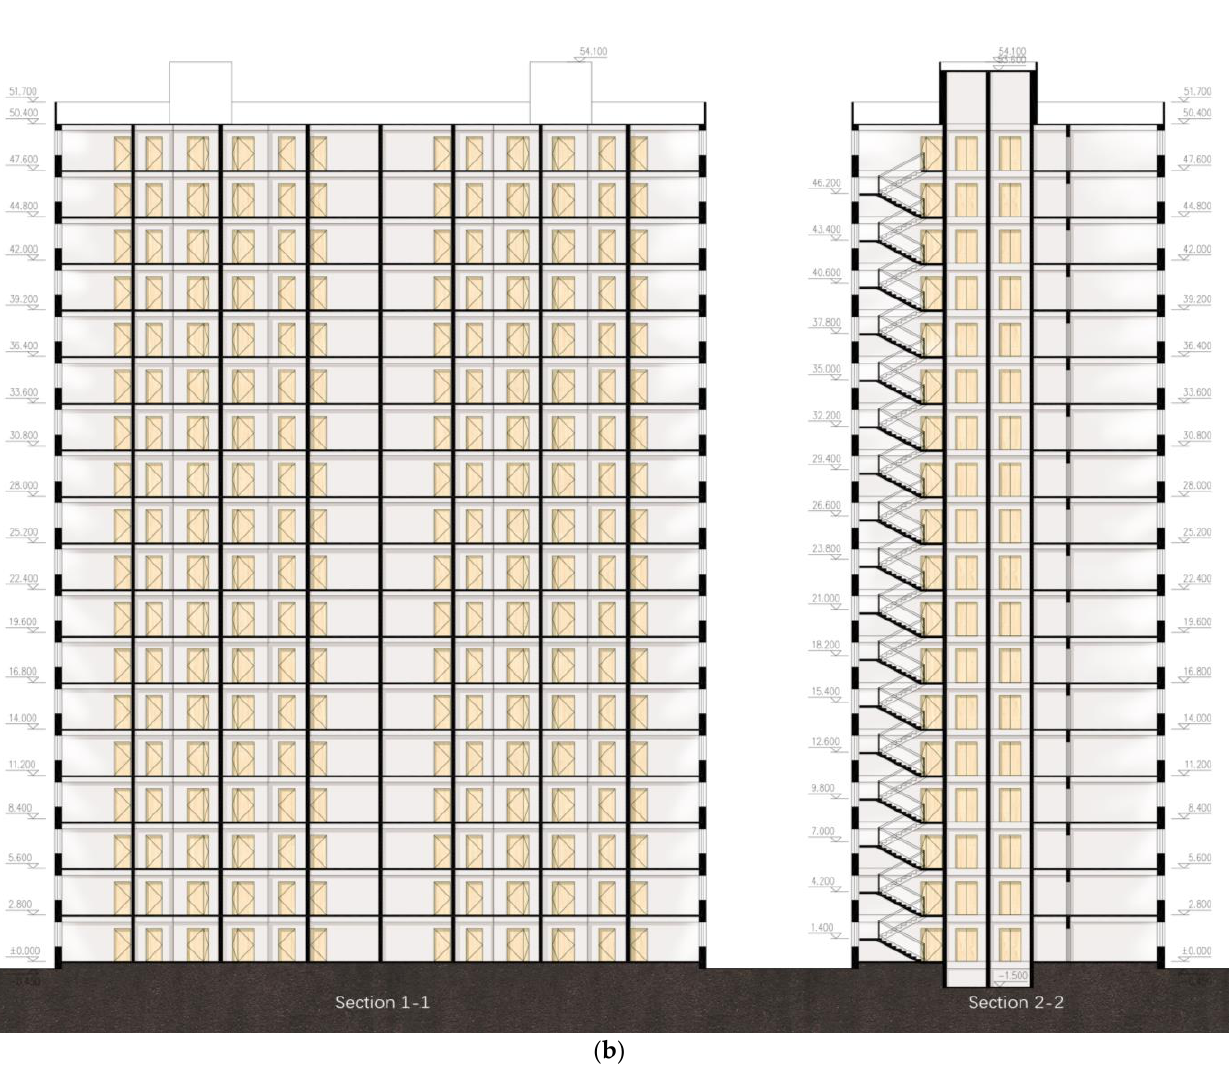
Figure 5. Details of the architectural case; drawn by the authors. ( a ) Standard floor plan of the residential building. ( b ) Sections 1-1 and 2-2 of the residential building. Table 3. Building information.